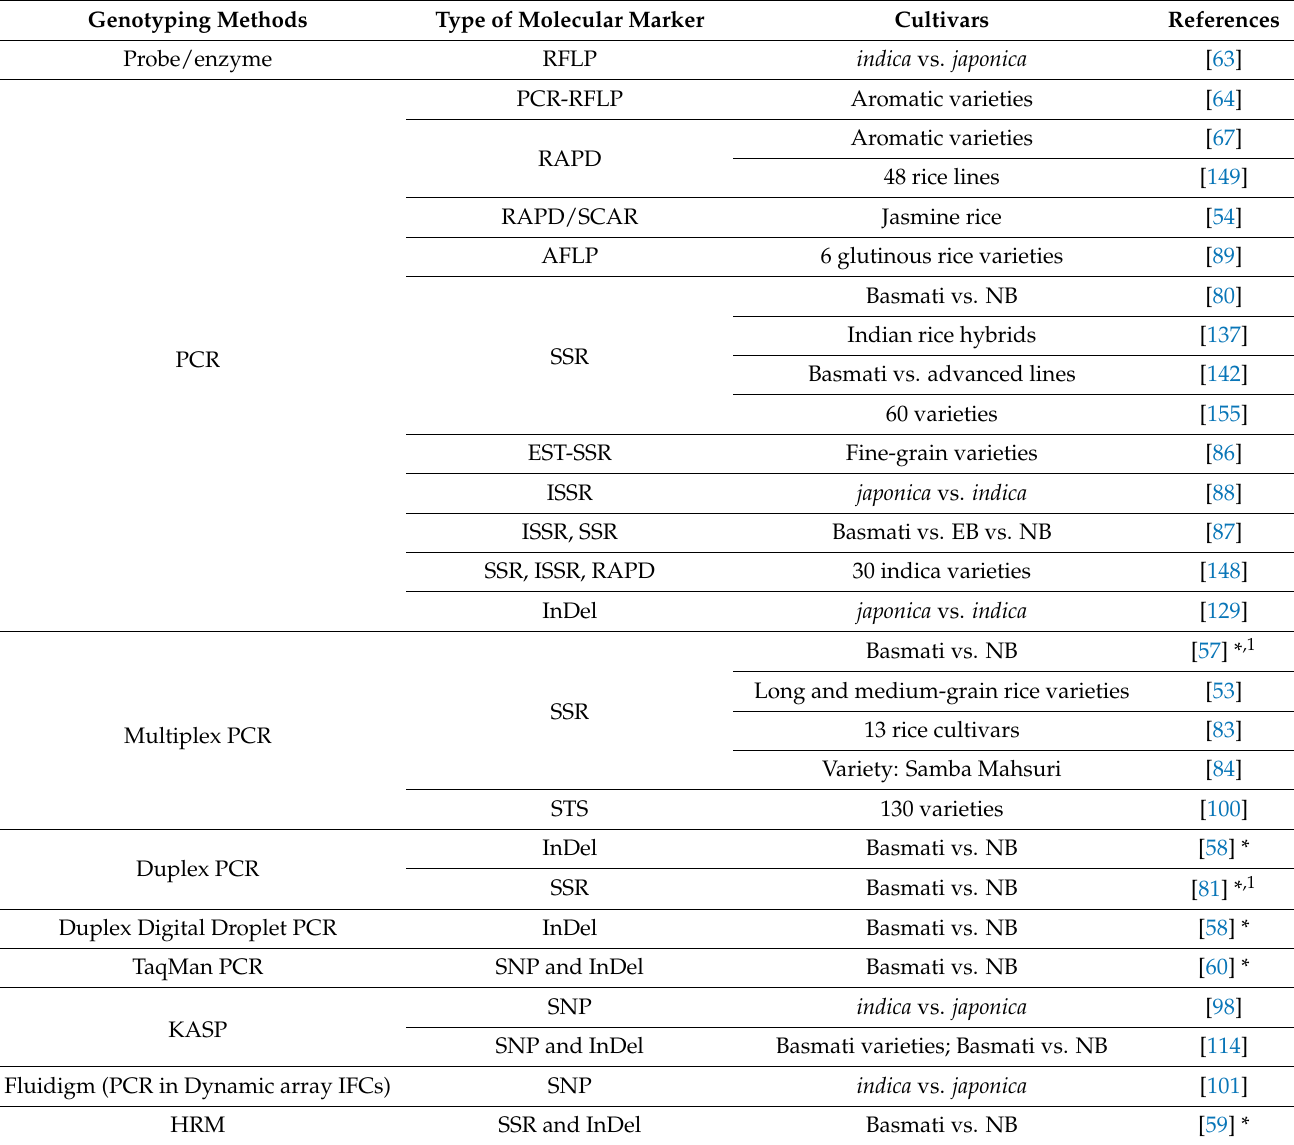
Table 1. DNA-based techniques used for cultivar identification, mentioned in this